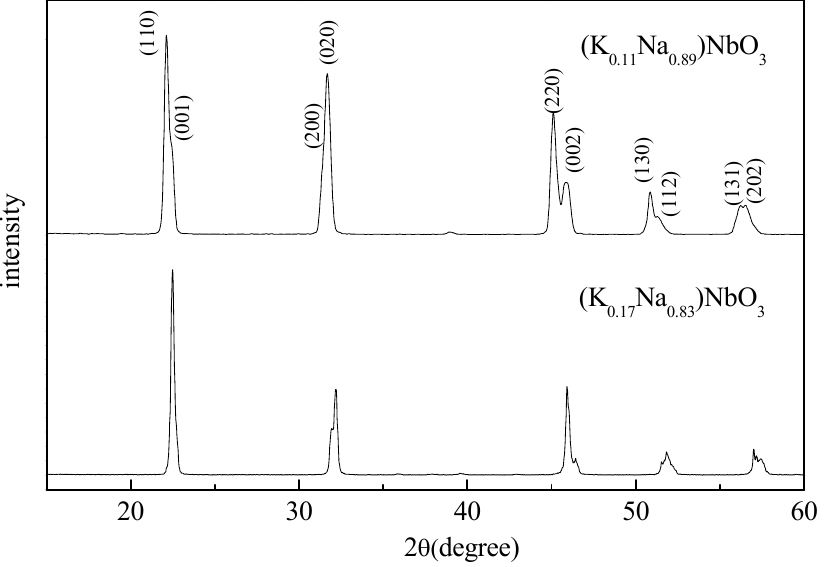
Na )NbO ( x = 0.11 and 0.17) x 1 − x 3